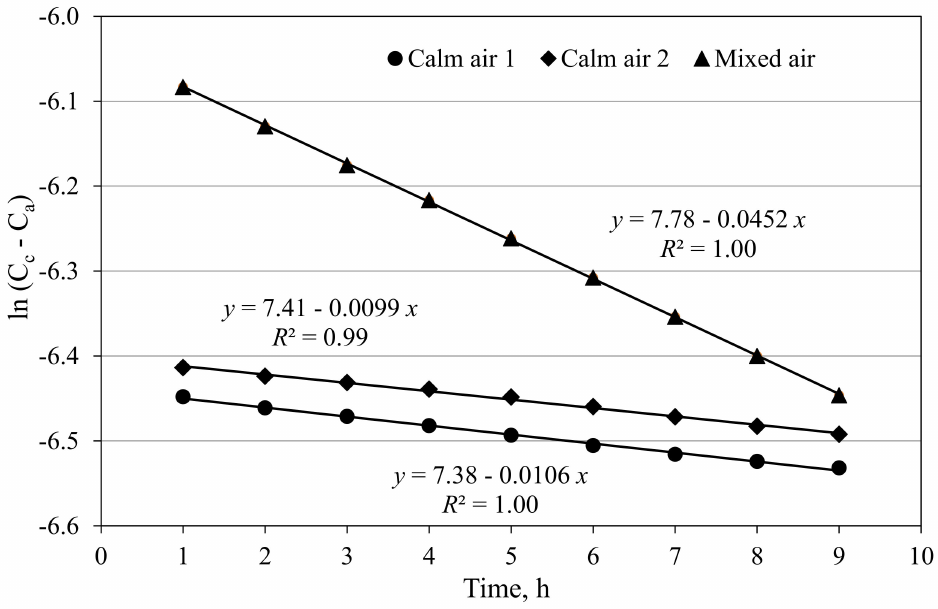
Figure 2. CO 2 depletion curves of two closed greenhouse cabins with calm air and one cabin where the air is blown through the open troughs, resulting in air exchange rates of 0.0099, 0.0106 and 0.0452 h − 1 ,